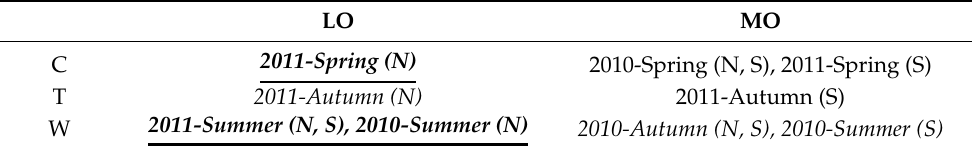
Table 3. Grouping cruises (Year-Season (Station)) according to the PCA grouping results. All cruises were designated for three temperature groups according to their PC1 scores (C = Cool, T = Temperate, W = Warm), and each group was divided into two subgroups according to their PC2 scores (LO = Less-oxygenated, MO = More-oxygenated). Bold text indicates the averaged bottom DO < 2 mg L − 1 , italic text indicates bottom p O 2 < P crit , and underlined text indicates p O 2 < P leth . LO